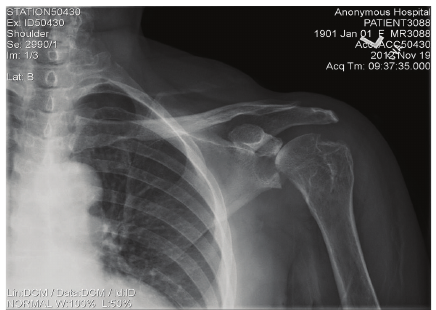
Figure 1: Reddish-brown papulonodular lesions on the dorsum of the hand.